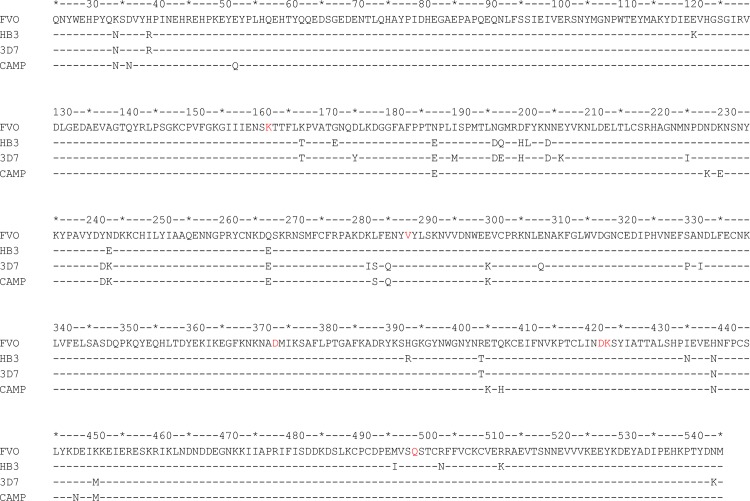
Comparison of protein sequences (aa25–545) of the for AMA1 antigen variants.All antigens were produced in Pichia pastoris and devoid of N-glycosylation sites. These have been replaced with amino acid residues (indicated in red) that occur in AMA1 sequences from other Plasmodium parasites (N162K, T288V, S373D, N422D, S423K, N499Q). Each protein consists of a portion of the prodomain (aa25–96), domain I (aa97–315), domain II (aa316–425) and domain III (aa426–545). All antigens reacted with the reduction-sensitive rat monoclonal antibody 4G2 on western blots (Faber et al 2008), which was taken as a surrogate measure of conformational integrity.